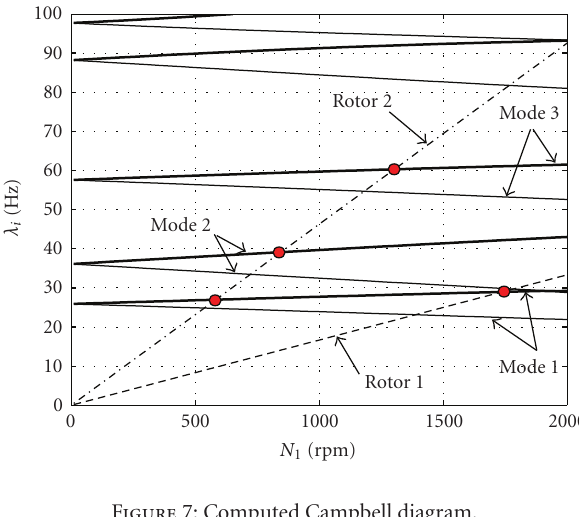
Figure 7: Computed Campbell diagram. Table 1: Critical speeds with respect to rotor